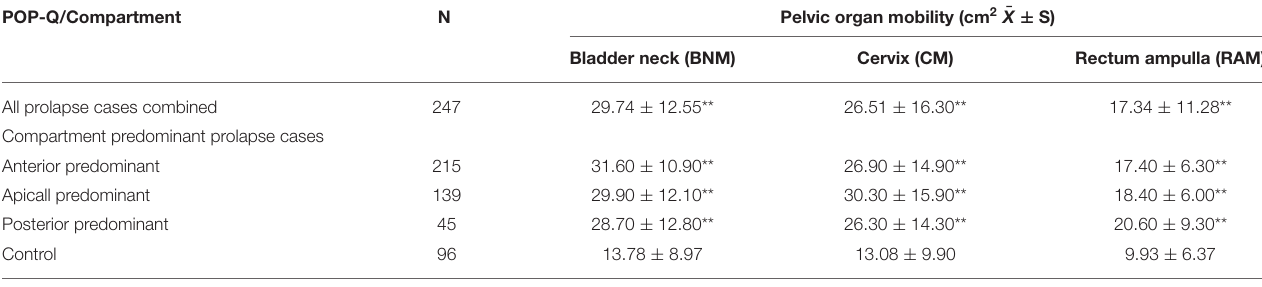
TABLE 4 | Comparison of pelvic organ mobility (difference between rest and Valsalva in the distance from the symphysis pubis to the bladder neck (BNM), cervix (CM) and rectum ampulla (RAM), as measured by transperineal ultrasound) between control, prolapse, and compartment predominant prolapse (International Continence